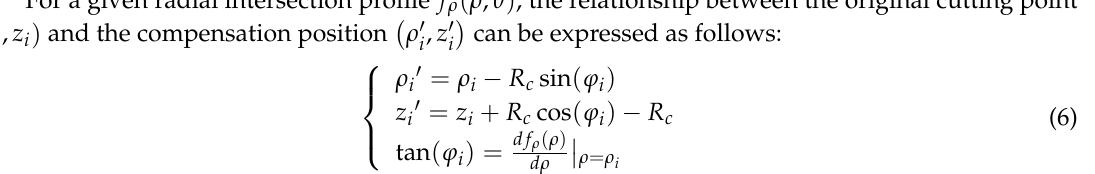
Figure 7. Tool radius compensation using normal direction method.